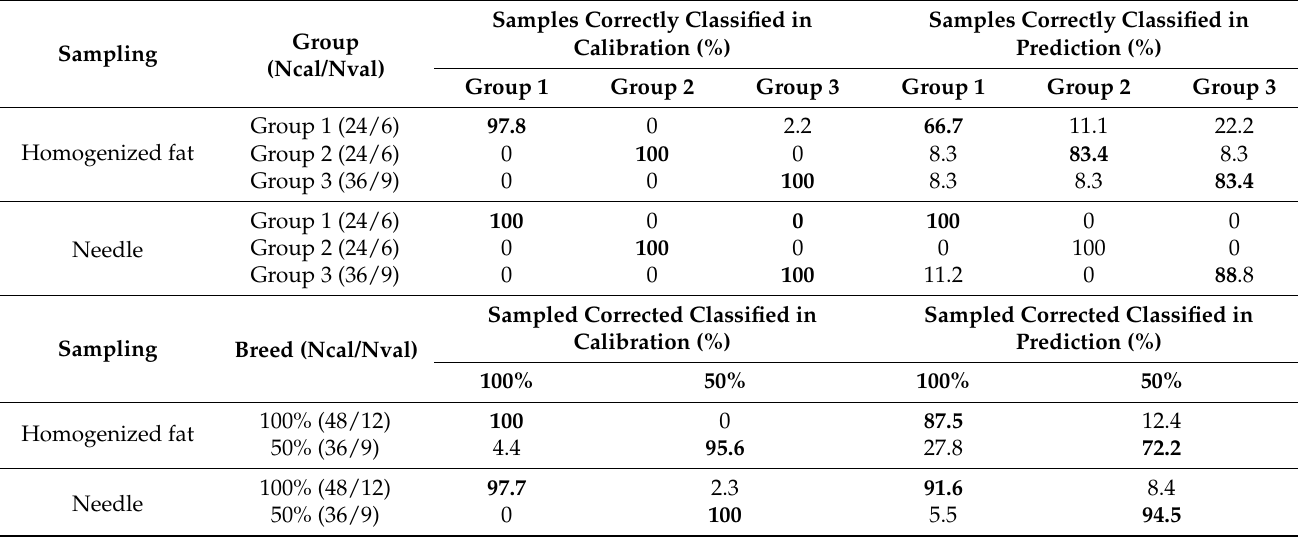
Table 1. Percentage of samples correctly classified (in bold) according to the days of montanera and breed using GC-IMS.